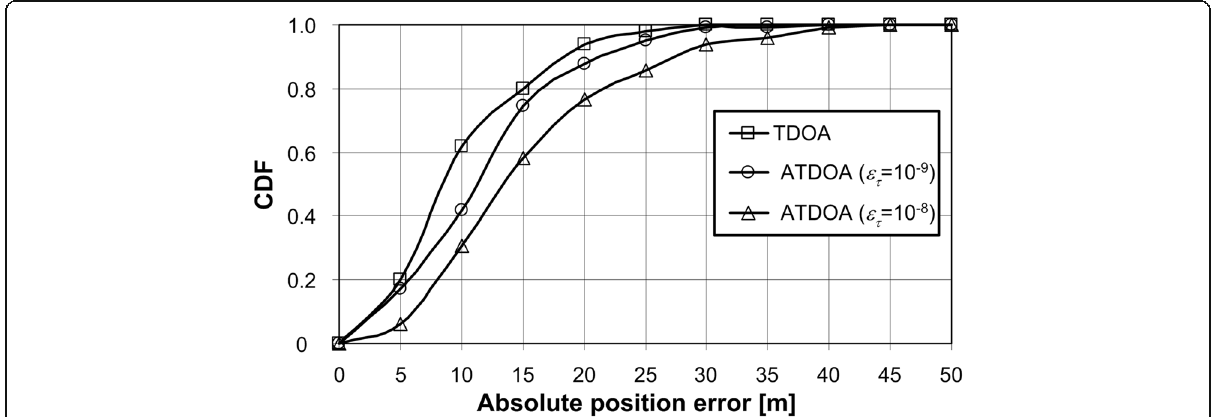
Fig. 10 The CDFs of the absolute position error for the proposed ATDOA method compared with the TDOA method using genetic algorithms during the